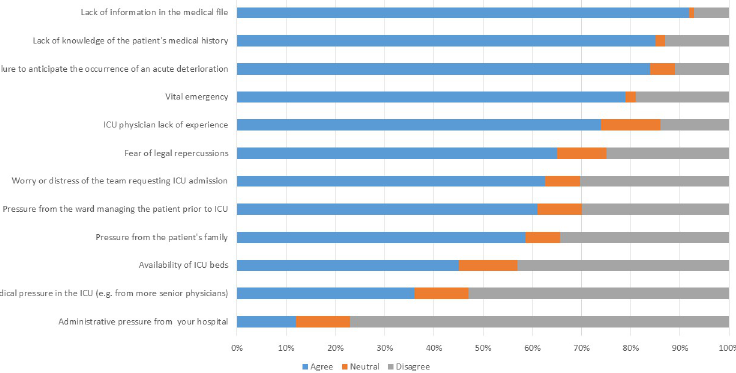
Fig 2. Level of reported agreement with the different circumstances that could result in the admission of a patient whose ICU stay will ultimately come to be deemed “non-beneficial” (Domain 2 of the